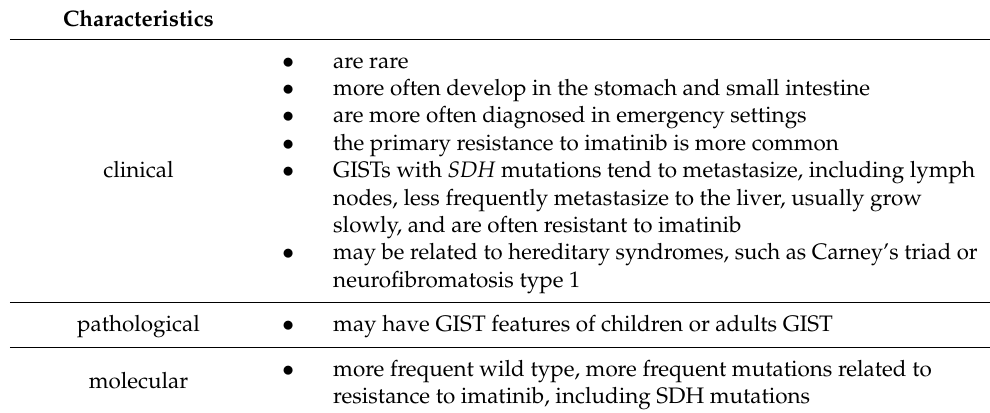
Table 1. Summary of the main characteristics of GISTs in young